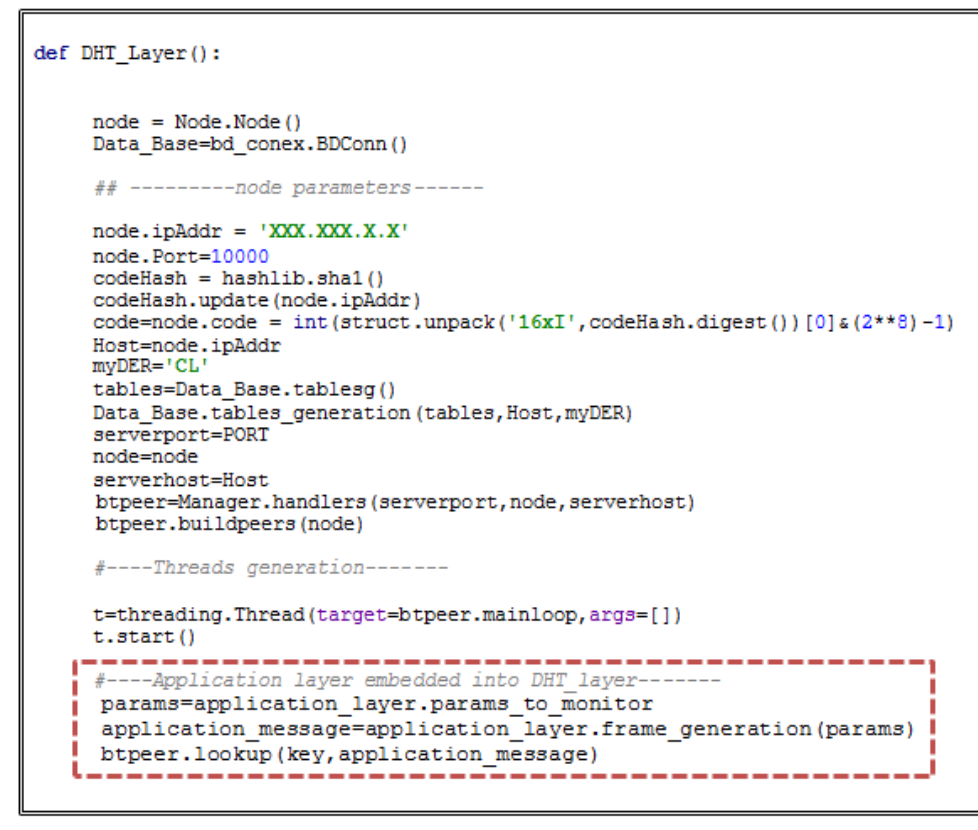
Figure 10. DHT layer pseudo-code. Detail of embedded application layer.